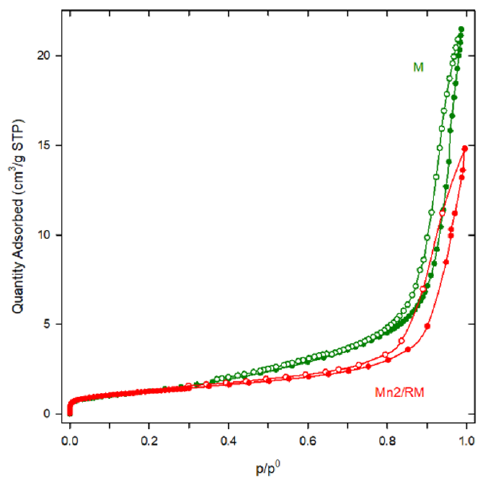
Figure 4. Nitrogen adsorption/desorption representative isotherms of some of the studied samples. Table 1. Textural properties of the studied samples.